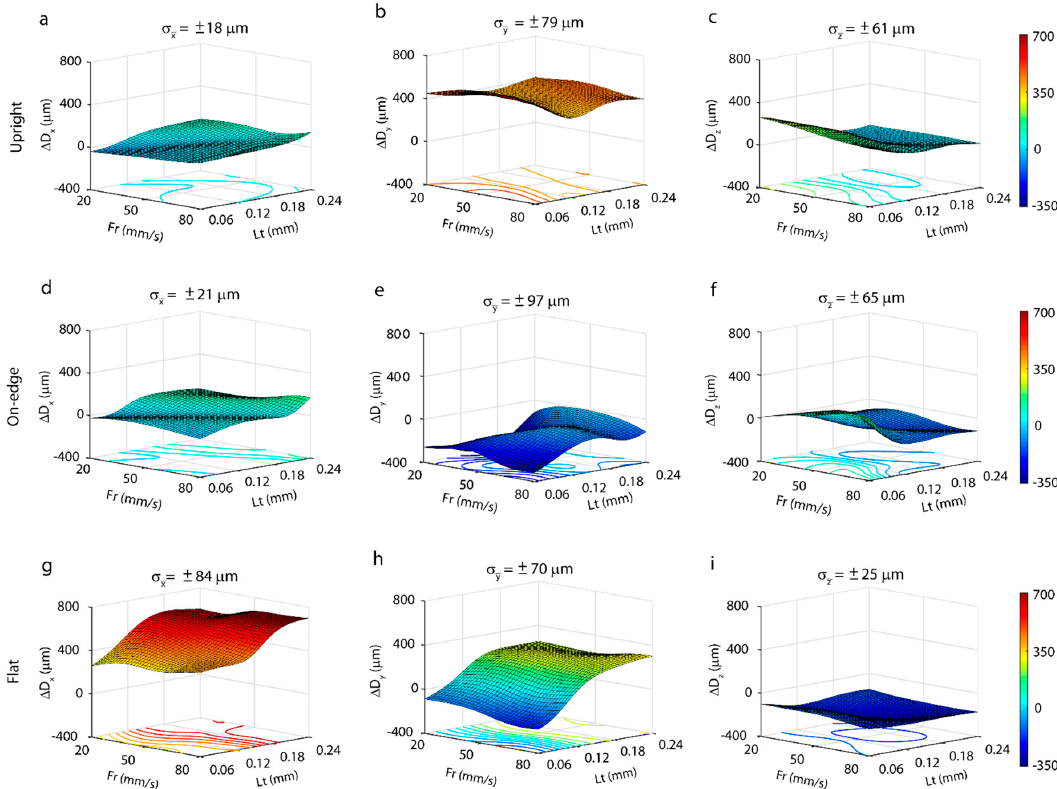
Figure 3. Characterization of dimensional deviation of polylactic acid (PLA) polymer processed by fused filament fabrication (FFF) for the three building orientations: Upright ( a – c ), on-edge ( d – f ), and flat ( g – i ).